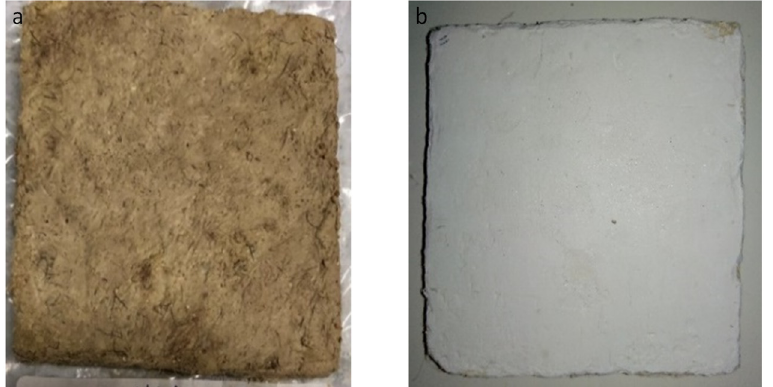
Figure 2. Sample S05 (100 × 100 mm 2 ), with sheep wool, thistle fibres and lime putty. The sample is showed without ( a ) and with ( b ) thermally conductive grease.